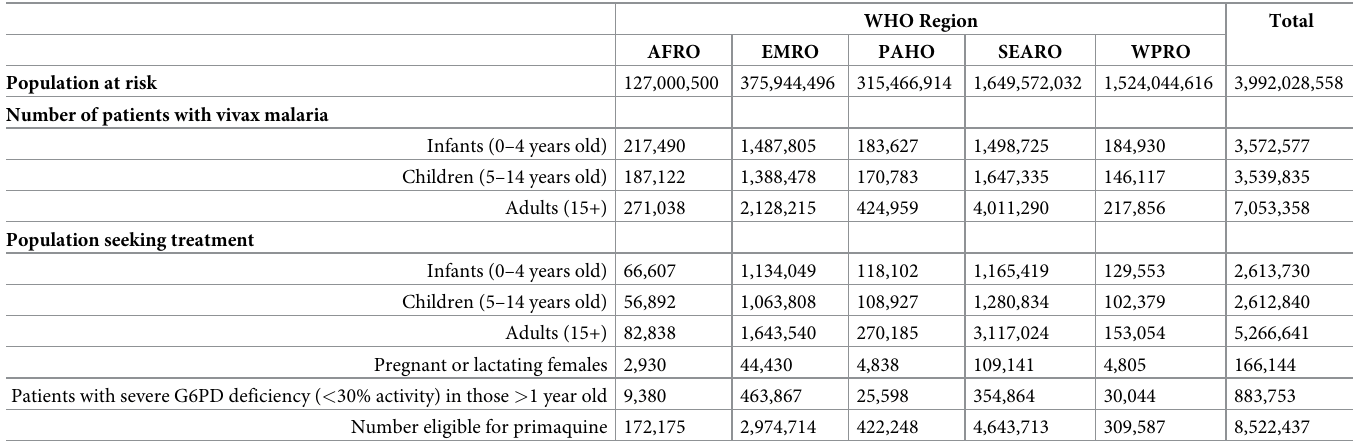
Table 1. Demographics and case numbers of patients with vivax